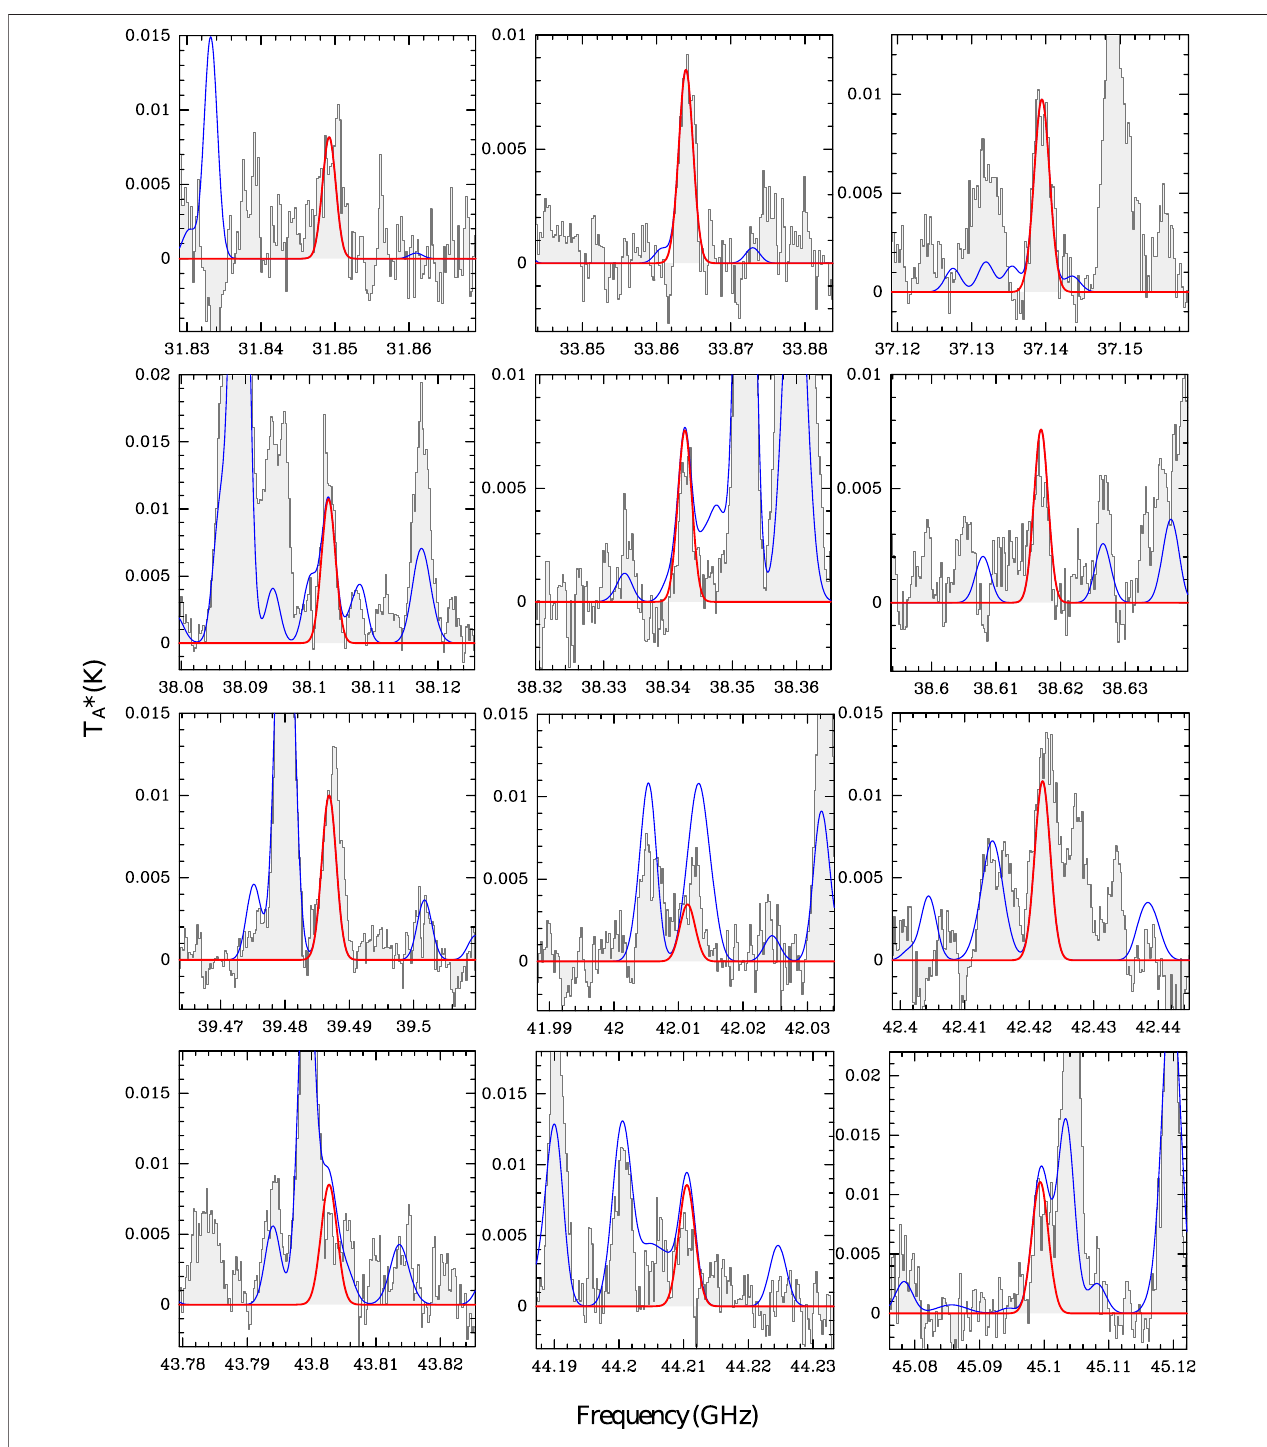
FIGURE 6 | Selected transitions of propargyl cyanide (HCCCH 2 CN; see Table 3 ) detected towards the G+0.693 molecular cloud. The best LTE fi t derived with MADCUBA for the HCCCH 2 CN emission is shown with a red curve, while the blue curve shows the total emission considering all the species identi fi ed towards this molecular cloud. The y-axis shows the line intensity in antenna temperature scale ( T A * ) in Kelvin, and the x-axis shows the frequency in GHz.